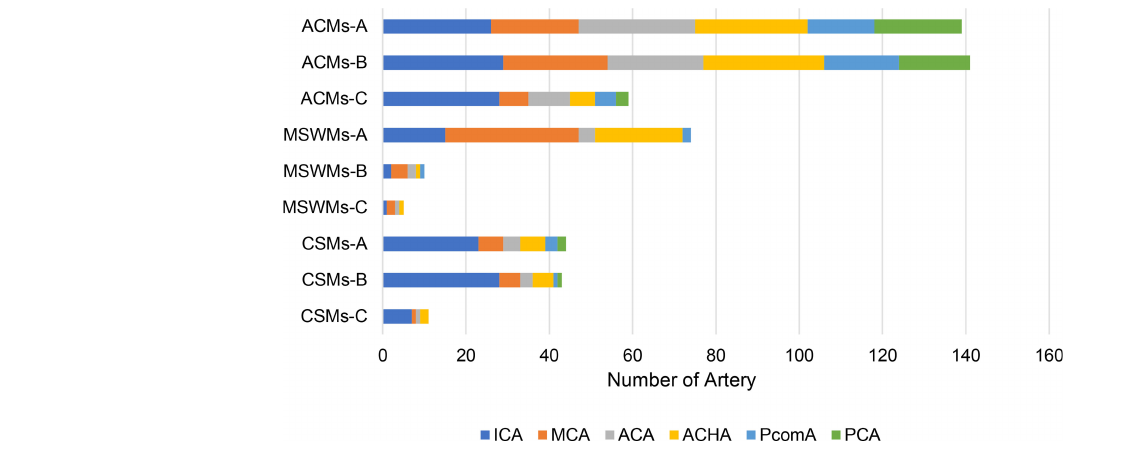
ICA was involved in most of ACMs and CSMs while MCA tend to be compressed or invaded by most of the